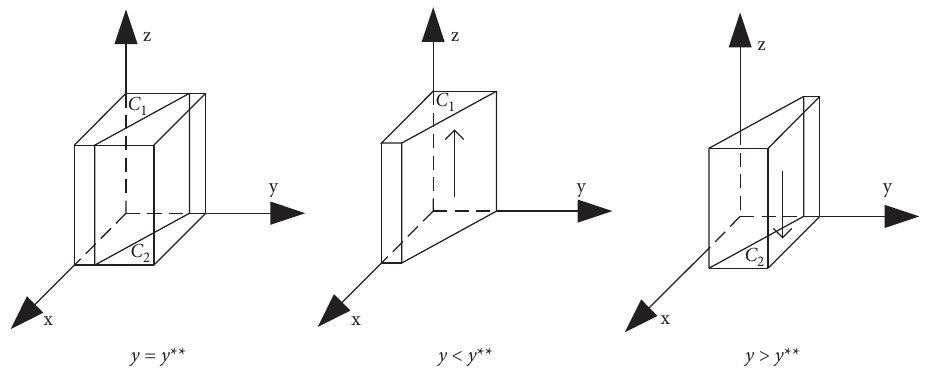
Figure 4: Strategy evolution phase diagram of the public